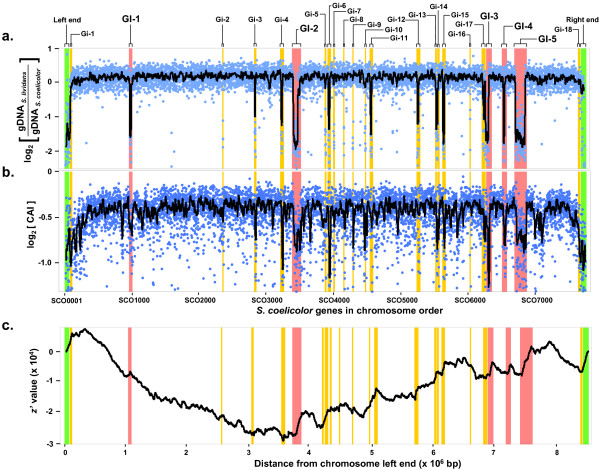
Comparative analysis of S. coelicolor M145 – S. lividans TK21 chromosomes and genomic features in S. coelicolor. (a) Log2 hybridization ratio as a function of S. coelicolor ORFs. Low values imply absence or divergence of gene in S. lividans. Experimental data (blue circles) and smoothened data using median of a 19-gene sliding window (thick line) are shown. Large genomic islands (red), smaller islets (orange) and S. coelicolor specific chromosome end regions (green) identified in this study are marked with filled bars. The sizes of the bars approximate the extent of each island. GI and Gi numbers corresponding to those in Table 1 are indicated. Note that the smoothened curve, shown here for ease of visualization, will not show a dip in hybridization ratios for genomic islets with fewer than 10 genes. (b) Logarithm of codon adaptation index (CAI) as a function of S. coelicolor ORFs. Low log2 CAI implies sub-optimal codon usage. (c) z' value plotted as a function of distance from chromosome left end. A sharp increase in z' value indicates presence of an AT-rich region. The figure shows that there exists a good correlation between presence of genomic islands, codon usage bias and local GC content.